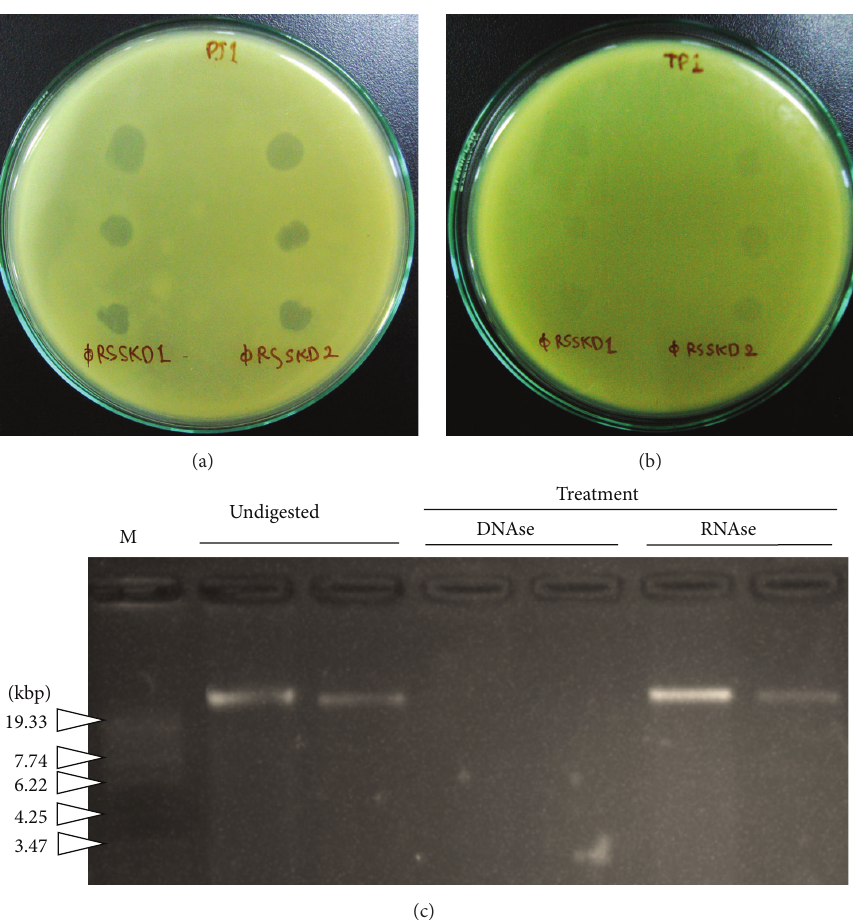
Figure 4: Spot assay on CPG medium showing different plaque morphologies which were clear (a) and turbid (b) plaques. Phage genome profiles which were treated/digested by two nucleases, DNAse and RNAse